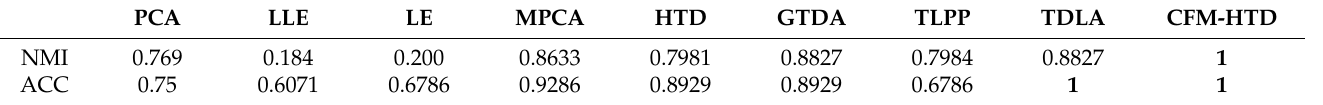
Table 2. ACC and NMI of different multisource fusion methods using dataset 1.